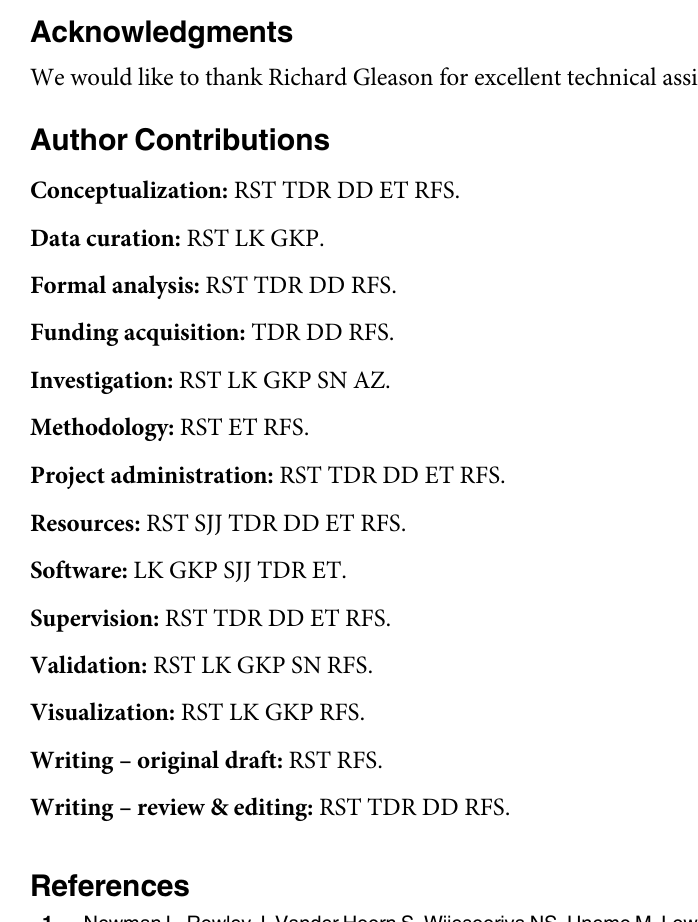
S1 Table. Sequences of Ct genomes used in alignments for primer design. (PDF) S2 Table. Sequences of primers used in the Ct 13-plex assay.